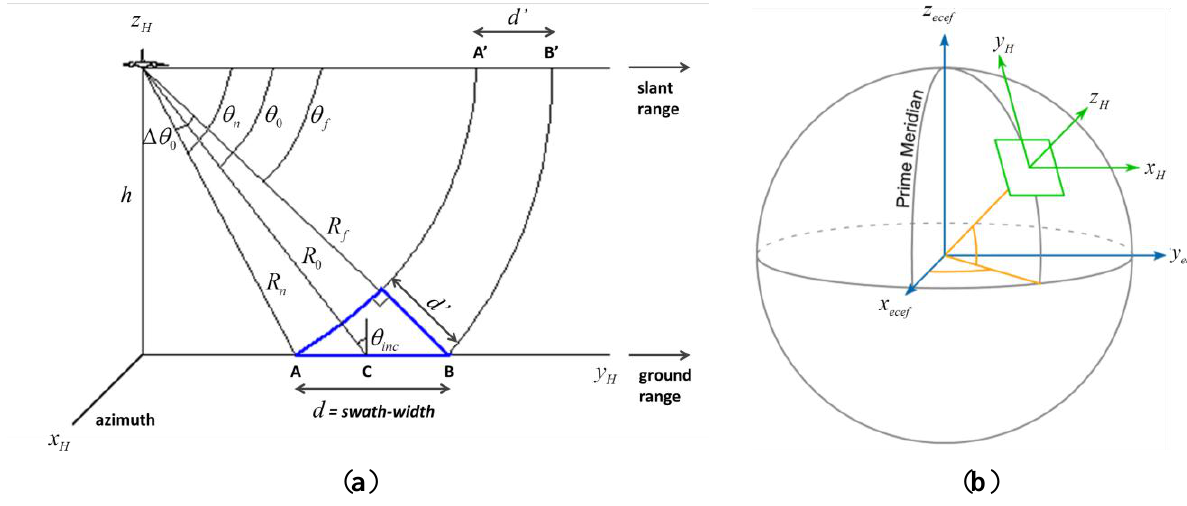
Figure 2. ( a ) Airborne side looking SAR geometry; ( b ) Basic flat-Earth geometry.